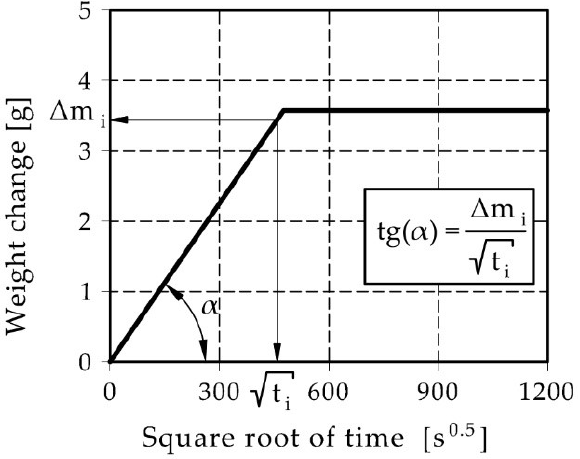
Figure 1. Tangent of slope of the initial section of the sample weight increments.